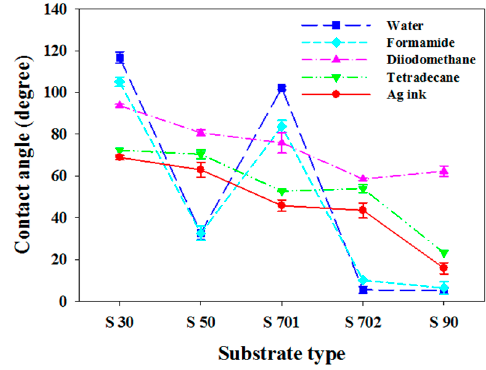
Figure 2. Contact angles of five test liquids on various types of substrates.